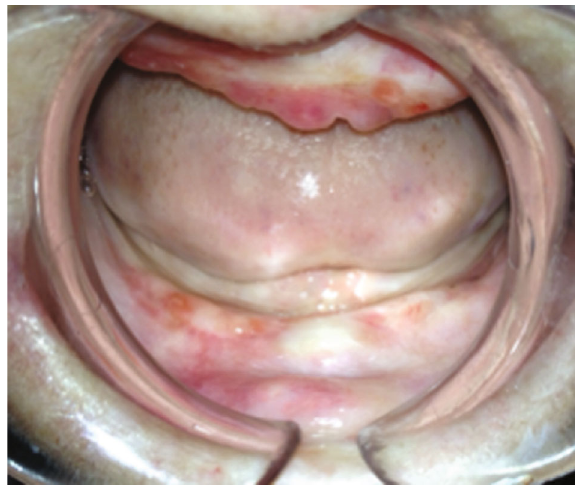
Figure 4: The image showing six-week postoperative healing after medicine treatment and